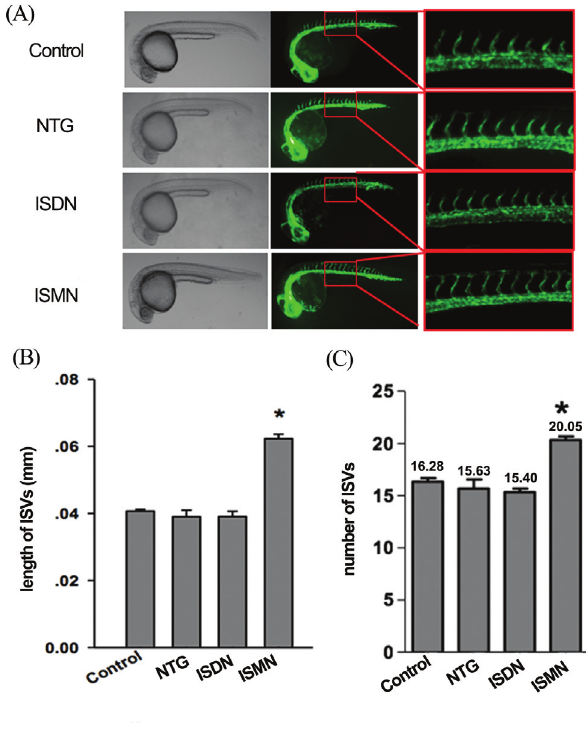
Figure 2 - Effects of nitrates on angiogenesis of ISVs. (A) Fluorescence images of zebrafish embryos at 24 hpf treated with DMSO (control) and different nitrates. (B) The number of ISVs in zebrafish embryos treated with nitrates. (C) The length of ISVs in zebrafish embryos treated with ni- trates. Data were expressed as mean (cid:5) SD (n = 3). * p <